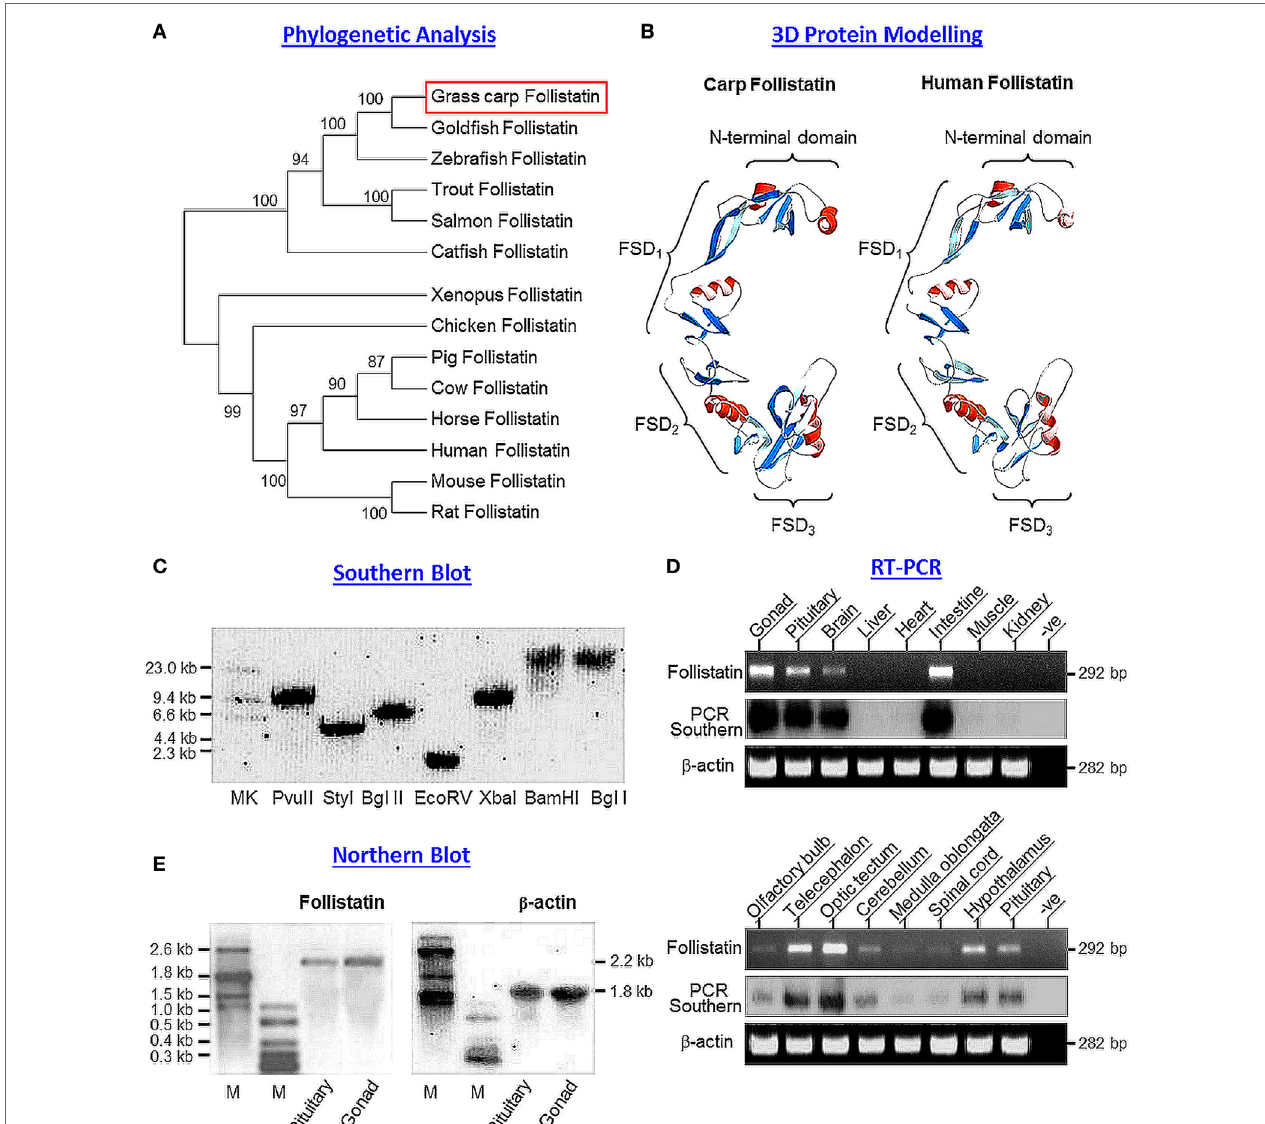
FigUre 1 | Sequence analysis, gene copy number, and tissue expression of grass carp follistatin. (a) Phylogenetic analysis of carp follistatin cDNA with corresponding sequences reported in other species using neighbor-joining method with MEGA 6.0. The numbers presented with the guide tree are the percentage of bootstrap values based on a 1,000 bootstraps. (B) 3D protein modeling of carp follistatin using SWISS-MODEL and DeepView with the crystal structure of human follistatin as the template. The regions in red and blue represent the helical motifs and β sheet structures, respectively, within the N-terminal and FSD 1–3 domains. The four structural domains can be clustered into a “concave” structure, which is known to be essential for activin binding. (c) Gene copy number for carp follistatin deduced by genomic Southern. Southern blot was conducted with a DIG-labeled probe for follistatin in carp genomic DNA with prior digestion of restriction enzymes as indicated. (D) Tissue expression of follistatin in grass carp. Total RNA was isolated from selected tissues and brain areas as indicated and subjected to RT-PCR with primers specific for follistatin. The authenticity of PCR product was confirmed by PCR Southern with DIG-labeled probe for follistatin with parallel PCR for β actin as internal control. (e) Characterization of follistatin transcript in the carp pituitary. Total RNA was isolated from the carp pituitary, resolved in 1% agarose gel and subjected to Northern blot with DIG-labeled probe for follistatin. In this experiment, total RNA prepared form the gonad was used as a positive control and parallel blotting for β actin transcript was used as the internal control (M: size markers for RNA